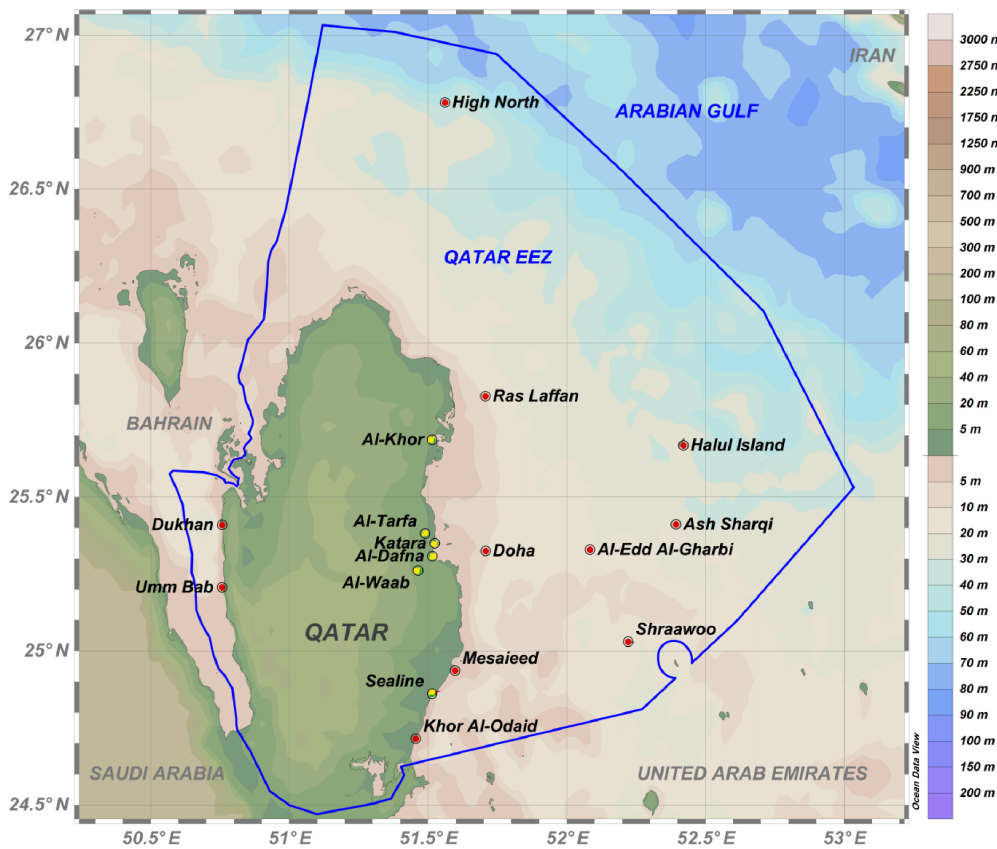
Figure 1. Plankton sampling locations (red dots) for the offshore sampling cruise in October 2012. The land-based sampling stations for atmospheric dust are shown with yellow dots. The Ocean Data View (ODV) program was used for plotting the figure (Schlitzer,